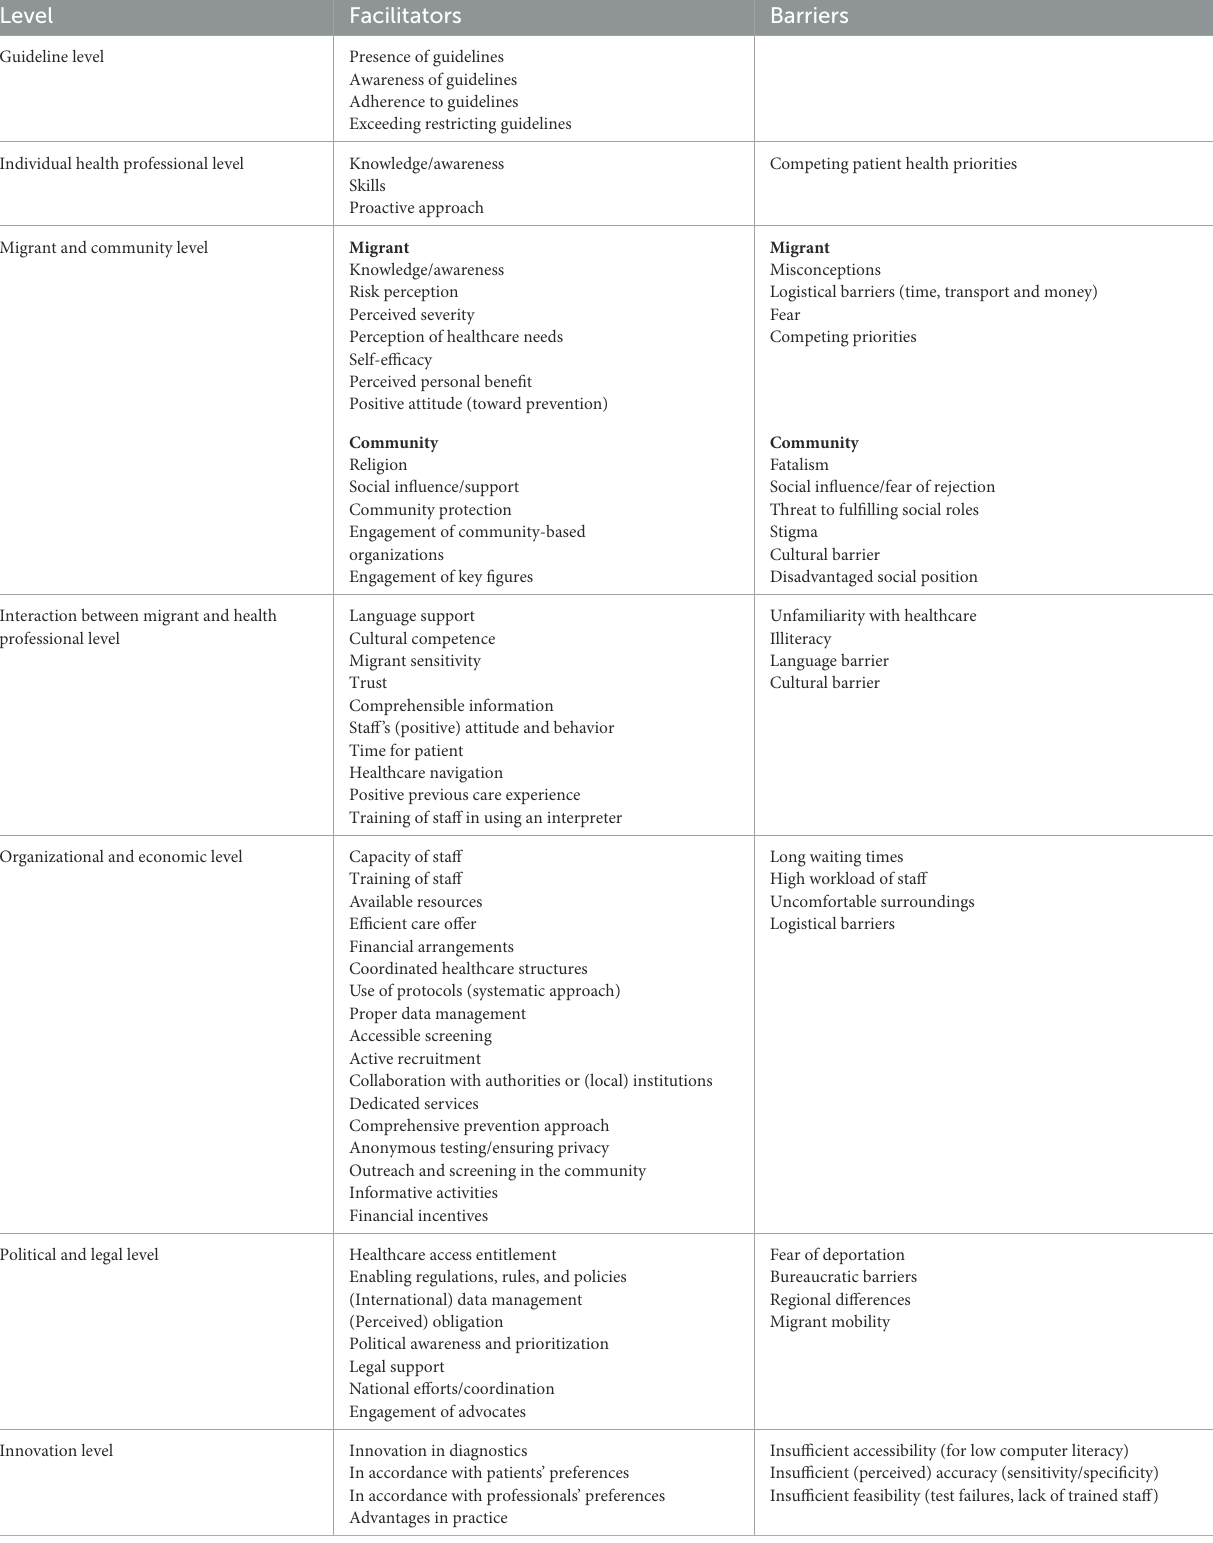
TABLE 1 Barriers and facilitators for HBV/HCV screening among